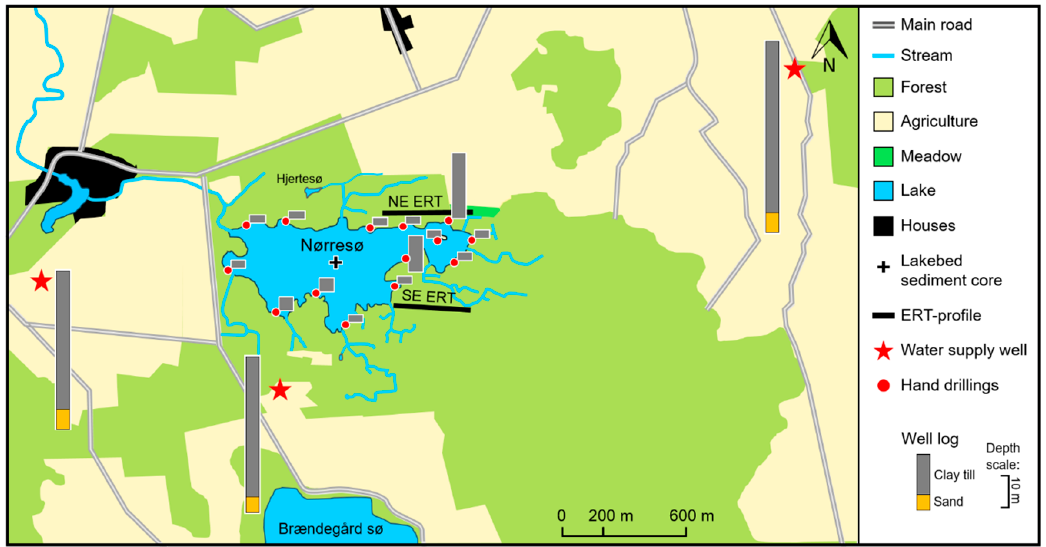
Figure 2. Overview of Nørresø and the surrounding area, and locations of piezometers, electrical resistivity tomography (ERT) profiles and the lakebed sediment core site. Lithological logs from the drillings (simplified to combine the shallow peat and the underlying clay till) and water supply wells are also included.